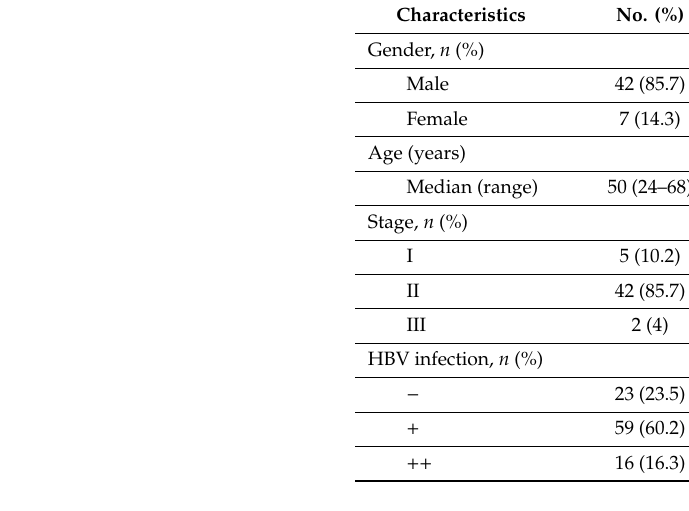
Table 1. Liver cancer tissue array (49 cases / 98 cores).